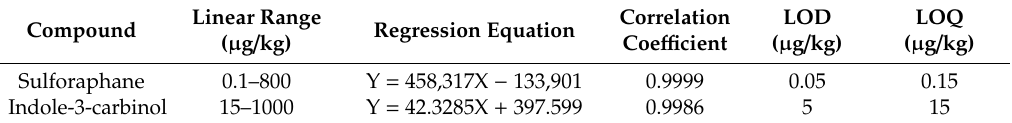
Table 1. Linear equations, correlation coe ffi cient (R 2 ), LODs, LOQs for sulforaphane and indole-3-carbinol.